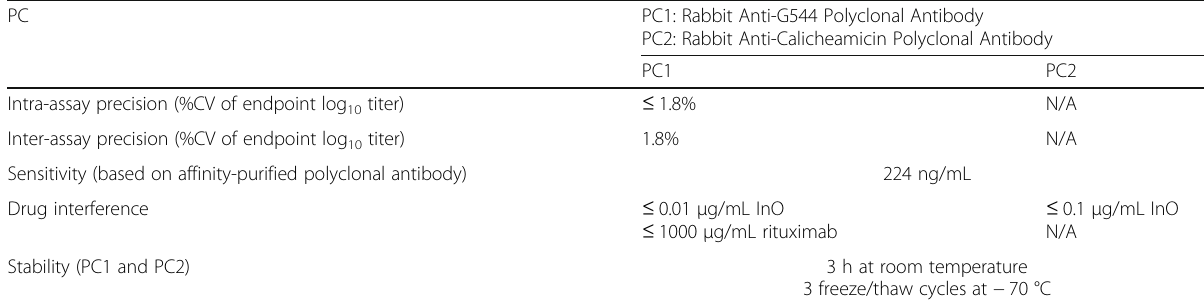
Table 4 Anti-InO antibody ELISA validation characteristics